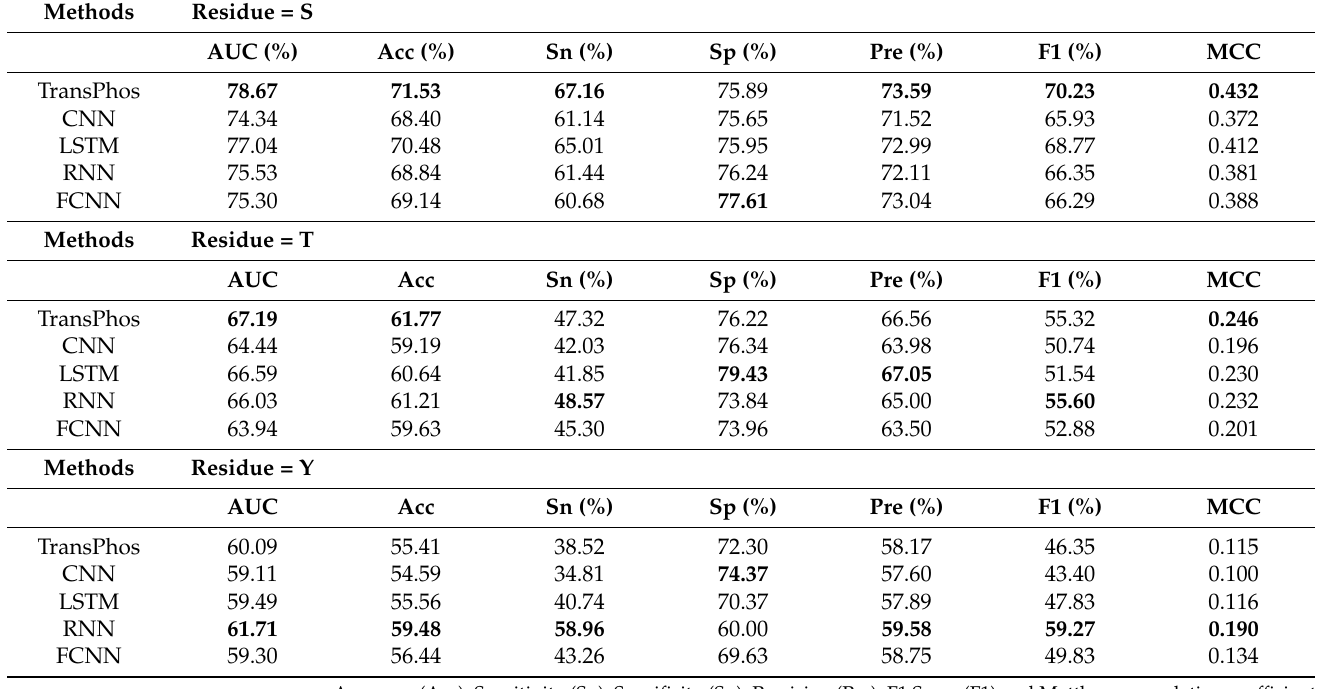
Table 2. Performance comparison of various deep learning models on the training dataset P.ELM, 10-fold cross validation was